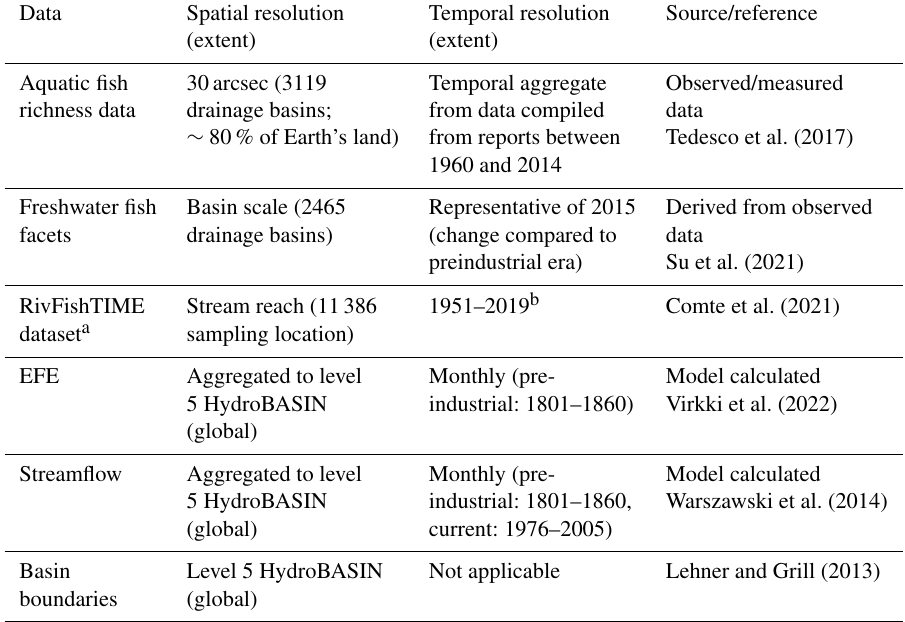
Table 1. Details of the different data used in this